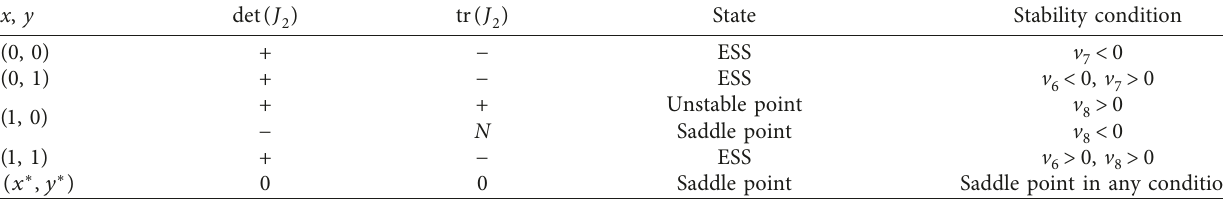
Table 4: Local stability analysis between the government and SMEs.